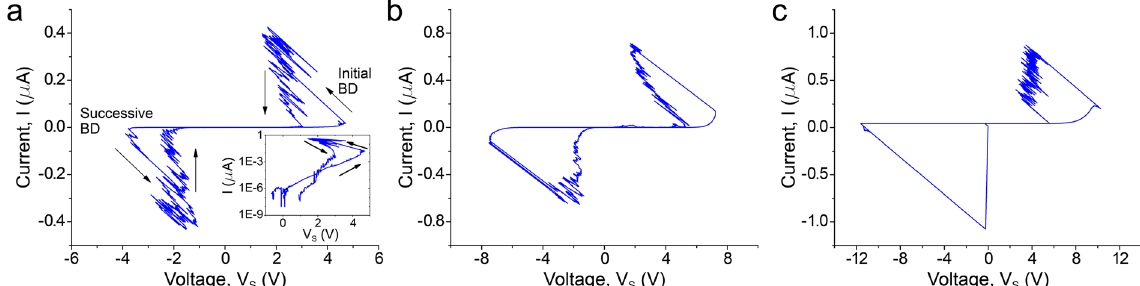
Figure 2. Current-voltage dependences of samples with alumina thicknesses equal to ( a ) 4 nm, ( b ) 6.5 nm and ( c ) 9 nm. The data plotted here corresponds to the first full period of the voltage curve (see Fig. 1(b)). Source voltage amplitude is ( a ) 6 V, ( b ) 9 V and ( c ) 12 V. Arrows serve as a guide to an eye. V s is the voltage between capacitor